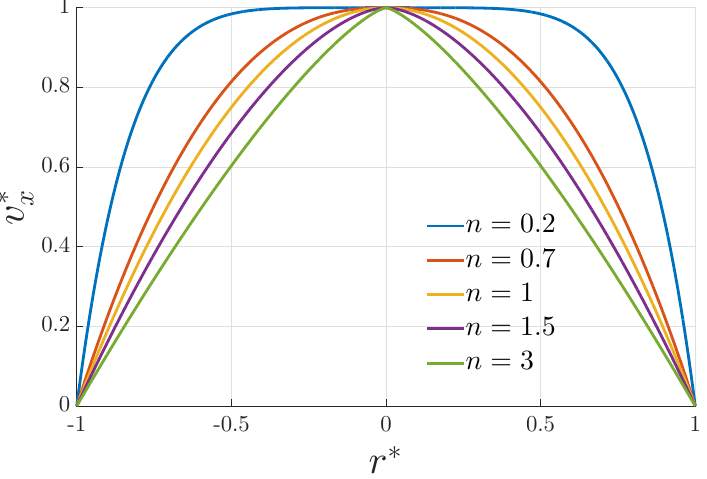
Figure 2. Plot of the velocity profile v x defined by Equation (11) normalized by V max and r ∗ = r / R